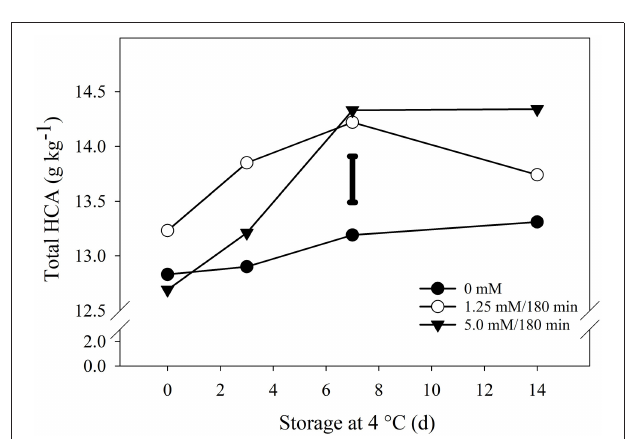
FIGURE 6 | Impact of hydrogen peroxide on total hydroxy-cinnamates. Broccoli florets were exposed to 0mM; 1.25 mM/180min (hormetic dose); and 5.0 mM/180min (high dose) H 2 O 2 , and then stored at 4 ◦ C/90–95% RH for 14 d. Contents of 1,2-diferuloyl gentiobiose; 1,2-disinapoyl gentiobiose; 1,2,2-trisinalpoyl gentiobiose; 1,2-disynalpoyl-2-feruloyl gentiobiose; and 1-sinapoyl-2-feruloyl gentiobiose were quantified and combined as g equivalents of sinigrin on a dry and represent the mean of 3 replicates per treatment ( n 3). The individual bar represents the LSD value (0.05) = Sampling on day 0 was performed 6h after the end of the